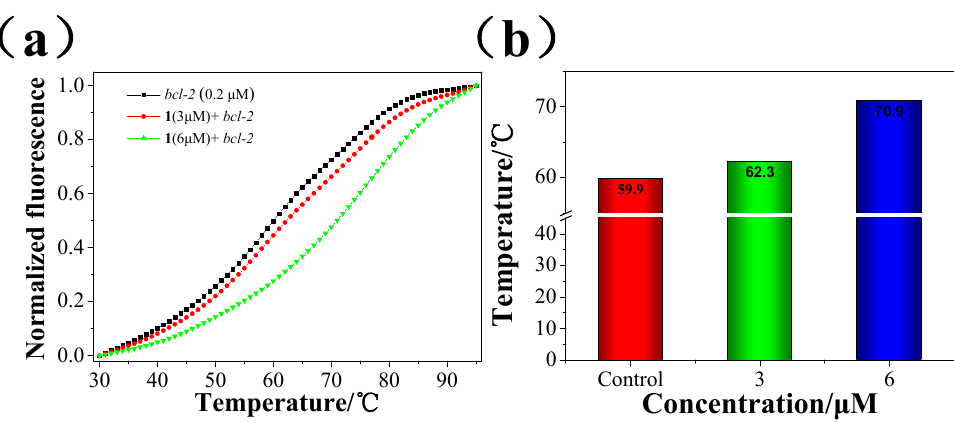
Figure 4. FRET melting profiles of bcl-2 G4 DNA in the absence and in presence of 1 ( a ) ([ bcl-2 G4 DNA] = 0.2 μ M) and the melting rising trend with the increasing of 1 ( b ).